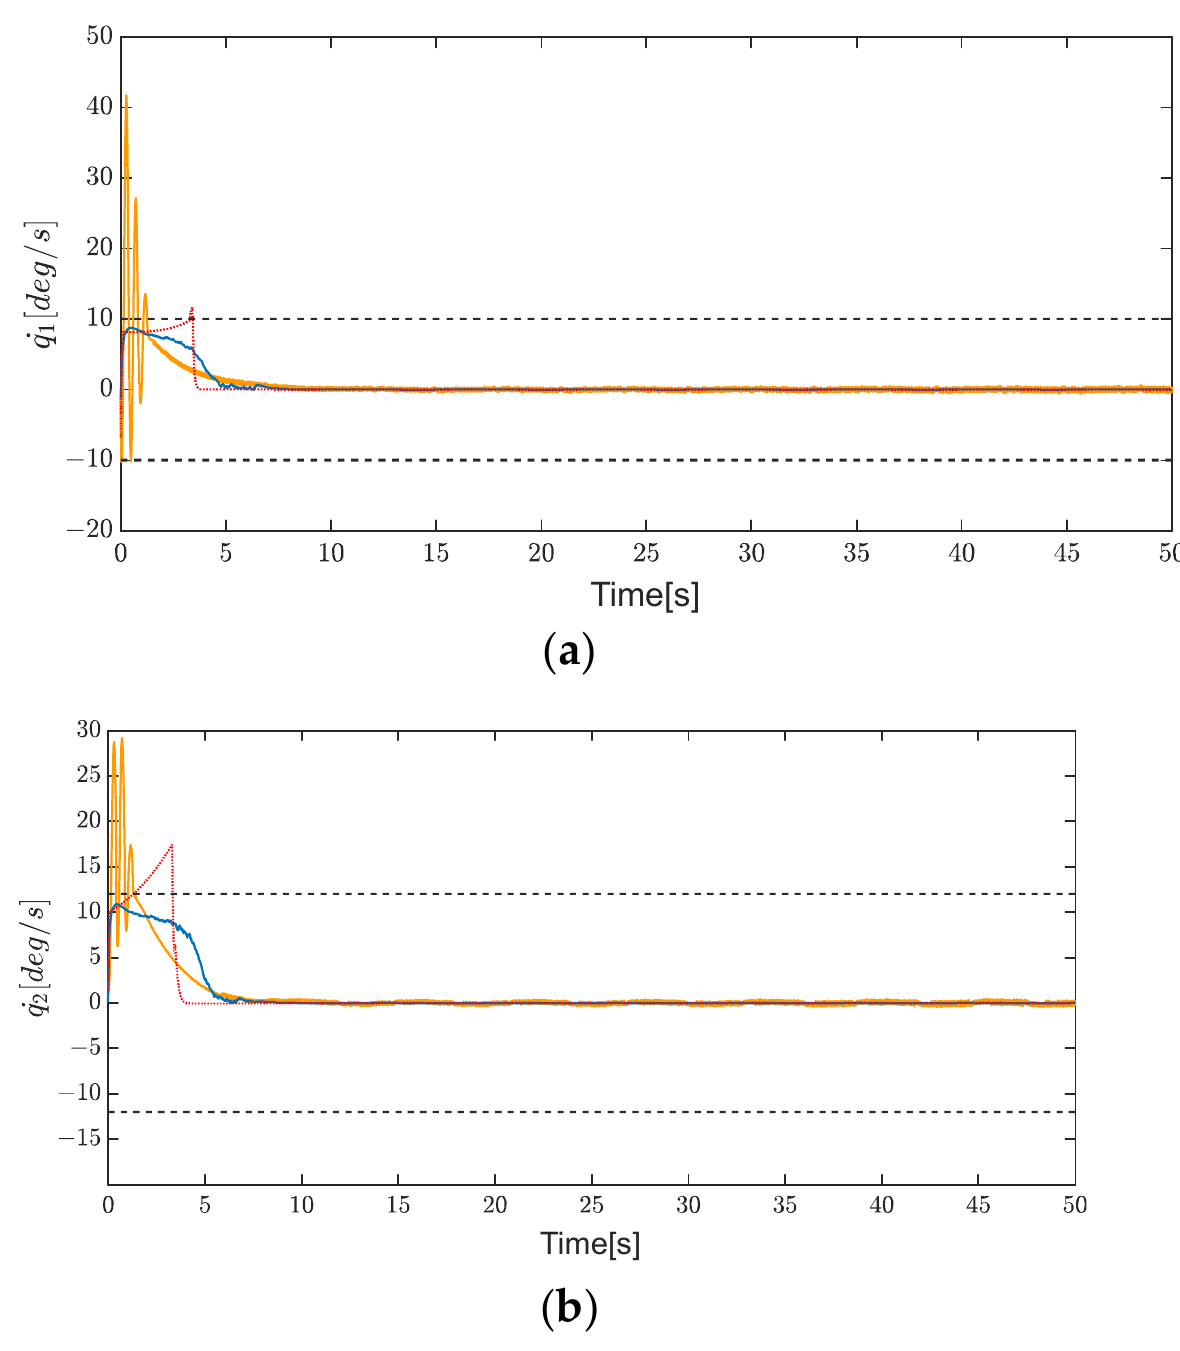
Figure 15. Comparison of angular velocity to [43,44] in case 2: the [43] scheme (yellow solid line), the [44] scheme (red dash line), the proposed scheme (blue solid line), the angular velocity constrains (black dashed line); ( a ) Joint 1. ( b ) Joint